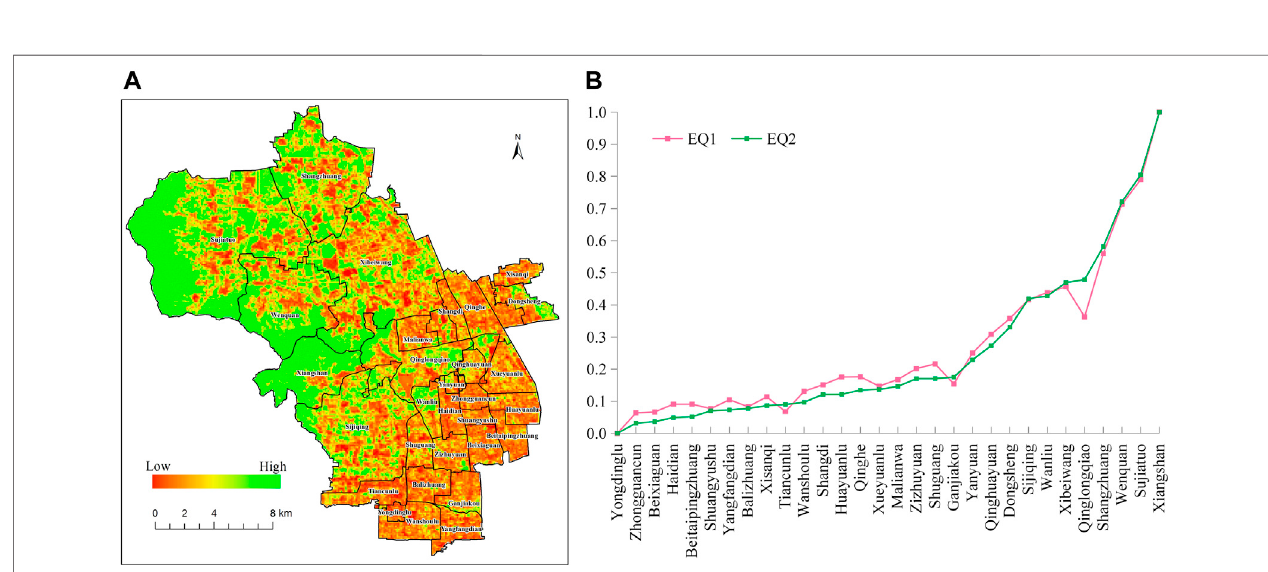
FIGURE 9 | Results of ecological quality evaluation (EQ2) with the linear model (A) , comparison to results with two methods (B) .